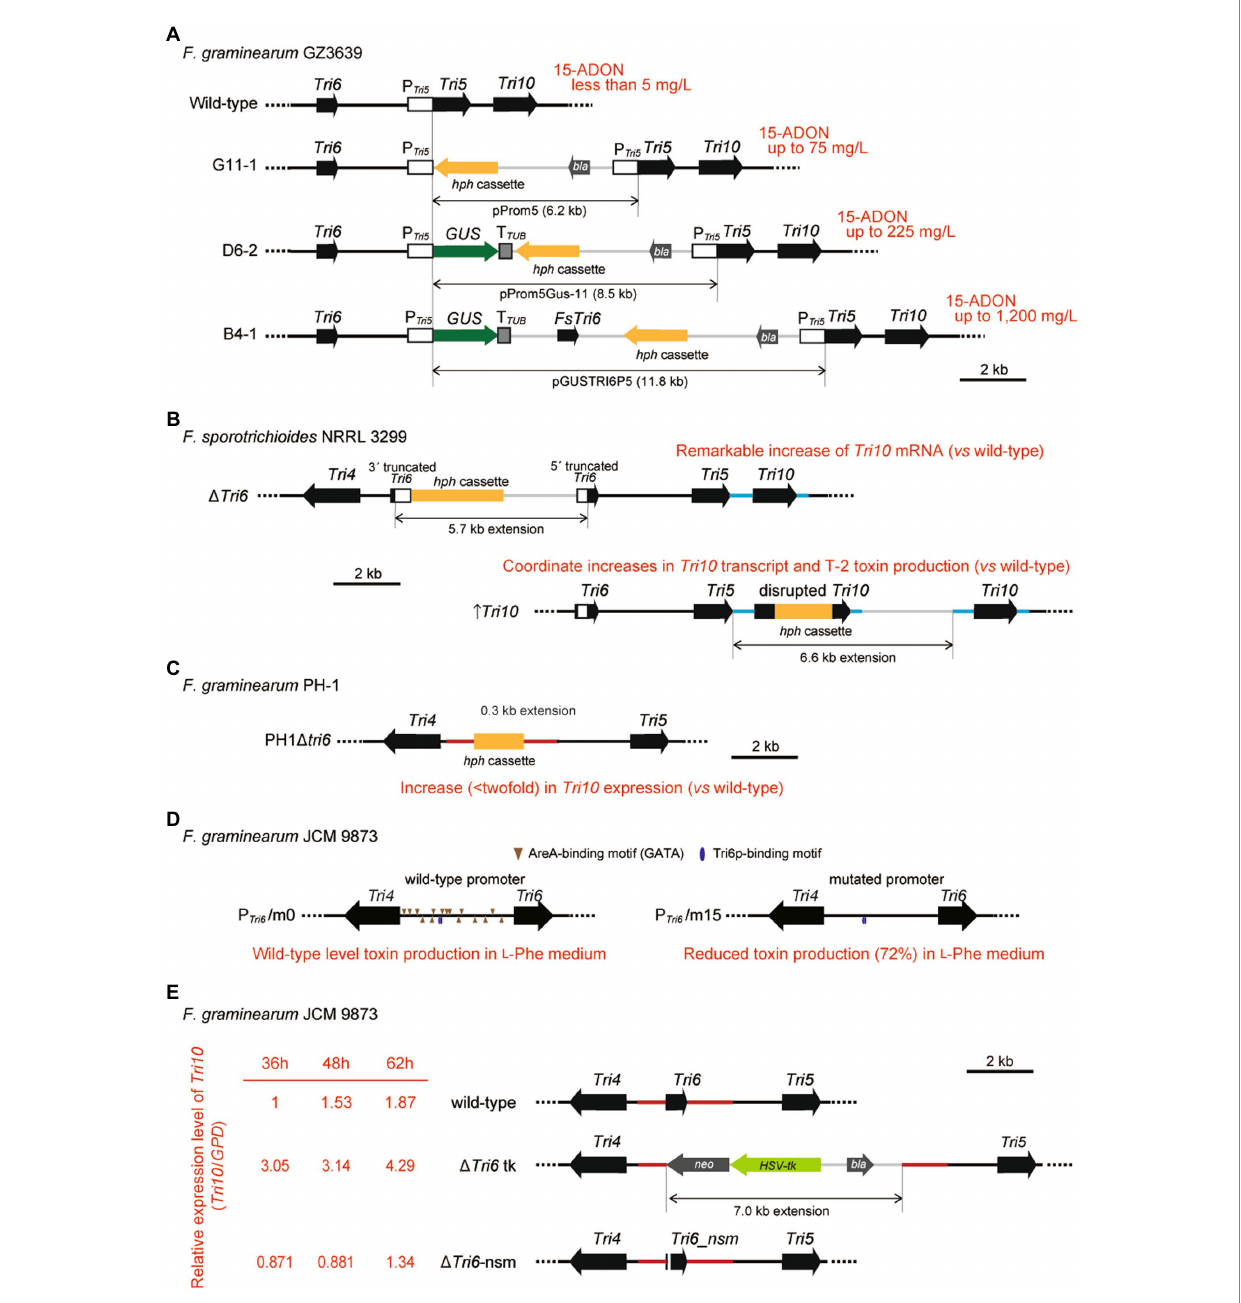
FIGURE 2 Genetic manipulations of the Tri4 – Tri6 – Tri5 – Tri10 locus in Fusarium . Deregulation of Tri6 and Tri10 occurs in cases when the targeted gene disruptions based on homologous recombination change the length of the core region of the trichothecene gene cluster. Vector integrations via single or double crossover homologous recombination for each subfigure are described in detail in Supplementary Figure 3. (A) Genetically engineered cluster core region of 15-ADON chemotype F. graminearum GZ3639 (Chen et al., 2000). The structure of the cluster core region is illustrated. Transformants, G11-1, D6-2, and B4-1, were obtained by homologous integration of vectors pProm5 (containing P Tri5 alone), pProm5GUS-11 (containing P Tri5 fused to GUS ; P Tri5 ::GUS ), and pGUSTRI6P5 (containing both P Tri5 ::GUS and FsTri6 ), respectively. Integration of pProm5, pProm5GUS-11, and pGUSTRI6P5 through the Tri5 promoter region extends the Tri5 – Tri6 intergenic region by 6.2 kb (G11-1), 8.5 kb (D6-2), and 11.8 kb (B4-1), respectively. While the wild-type GZ3639 accumulates less than 5 mg/L of trichothecenes by shake culture on liquid medium with glucose, elongation of the cluster core region resulted in increased production of 15-ADON (up to 75 mg/L by G11-1, up to 225 mg/L by D6-2, and up to 1,200 mg/L by B4-1), irrespective of the presence or absence of FsTri6 on the vector. Ectopic integration of pGUSTRI6P5 (e.g., up to 54 mg/l by strain B9-1; not shown in the subfigure) did not yield 15-ADON above the amount obtained by strain G11-1 lacking FsTri6 . Notably, compared with strain B9-1, much stronger GUS activity was detected from strain B4-1 (50- to 100-fold increase), in which P Tri5 ::GUS is located at the cluster core region. (B) Genetically engineered cluster core region of F. sporotrichioides strain NRRL 3299 (Tag et al., 2001). The structure of the cluster core region of each derived mutant strain is illustrated. The resulting Δ Tri6 strain contains a 3 ′ -truncated Tri6 gene followed by an hph cassette and then a 5 ′ -truncated Tri6 gene, and is expected to have a 5.7 kb extension at the Tri6 region. The ↑ Tri10 and Δ Tri10 strains were constructed from the same plasmid pTri10-1 which could undergo single or double